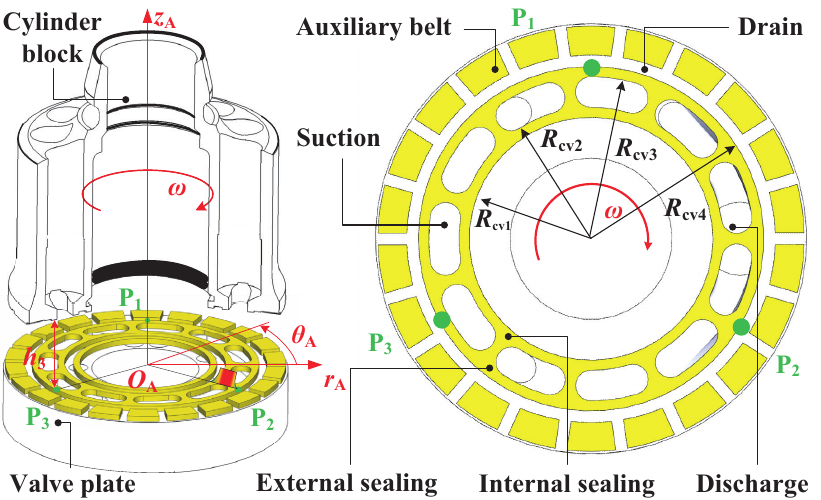
Figure 2. Geometry of the oil